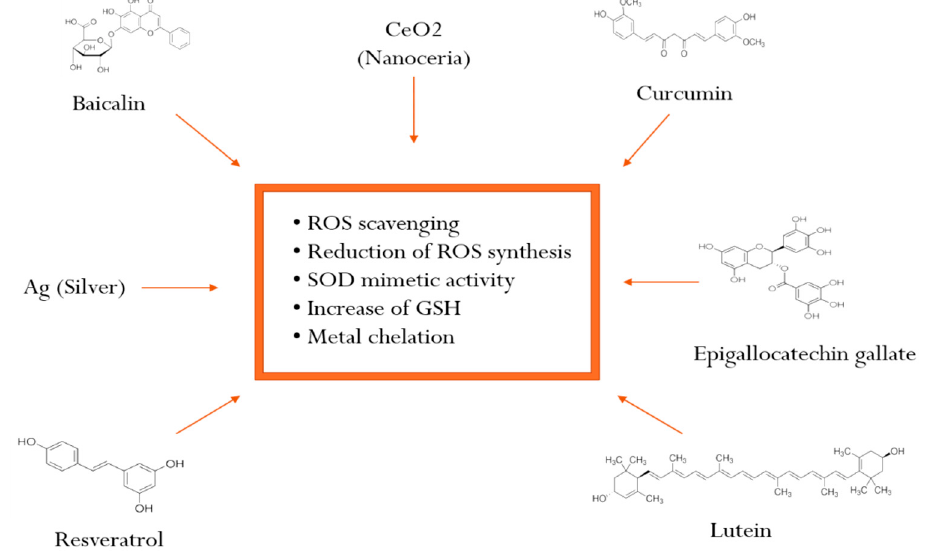
Figure 2. Mechanisms of action of antioxidants entrapped in ophthalmic nanosystems (Abbreviations: ROS: reactive oxygen species; SOD: superoxide dismutase; GSH: glutathione).